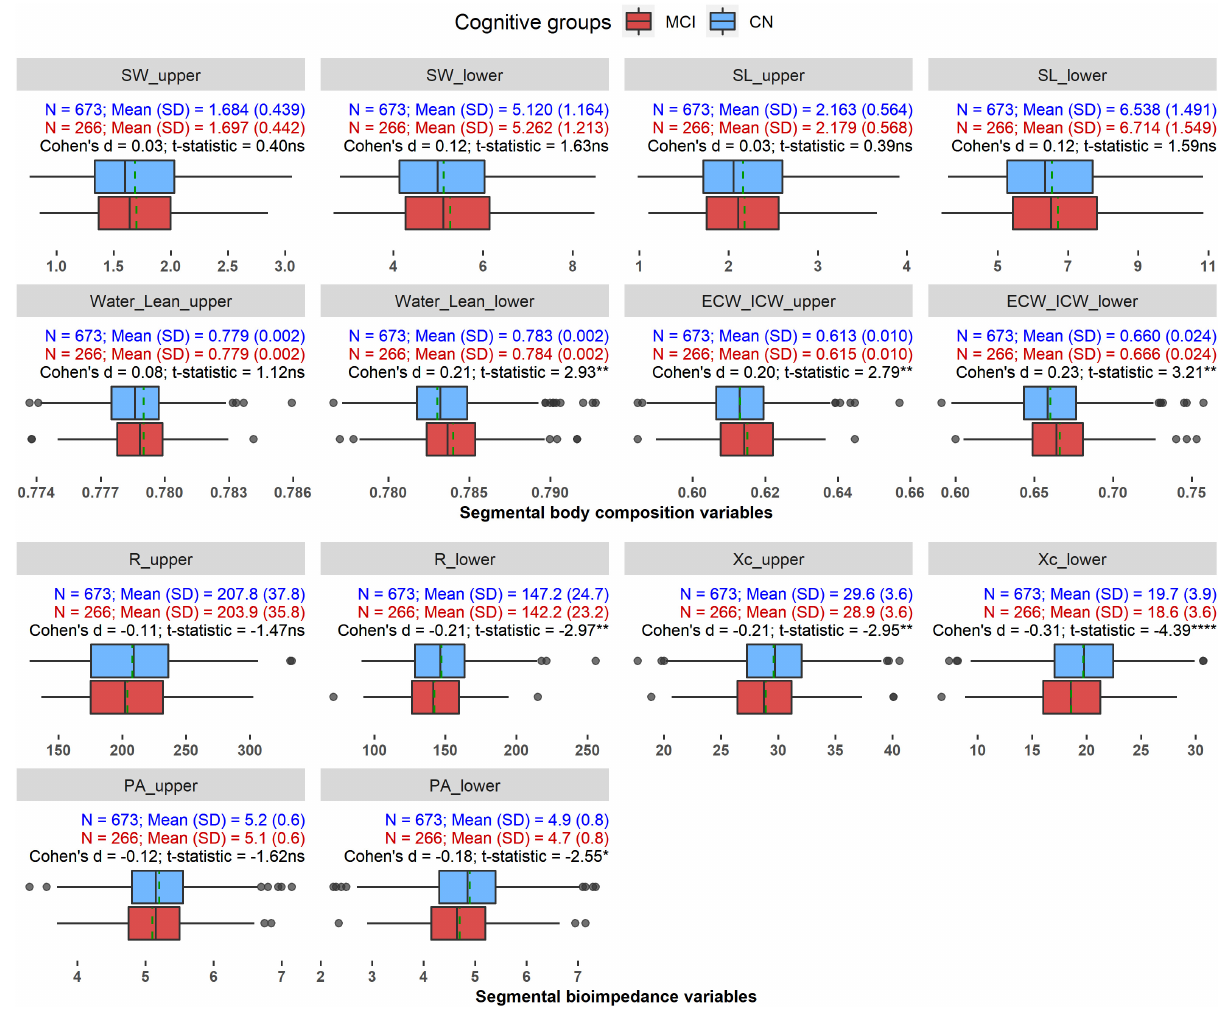
FIGURE 2 | The distributions of the segmental BIA variables in CN and MCI groups. * p < 0.05, ** p < 0.01, *** p < 0.0001, ns: Not significant. Dashed green line indicates mean value of each variable in each